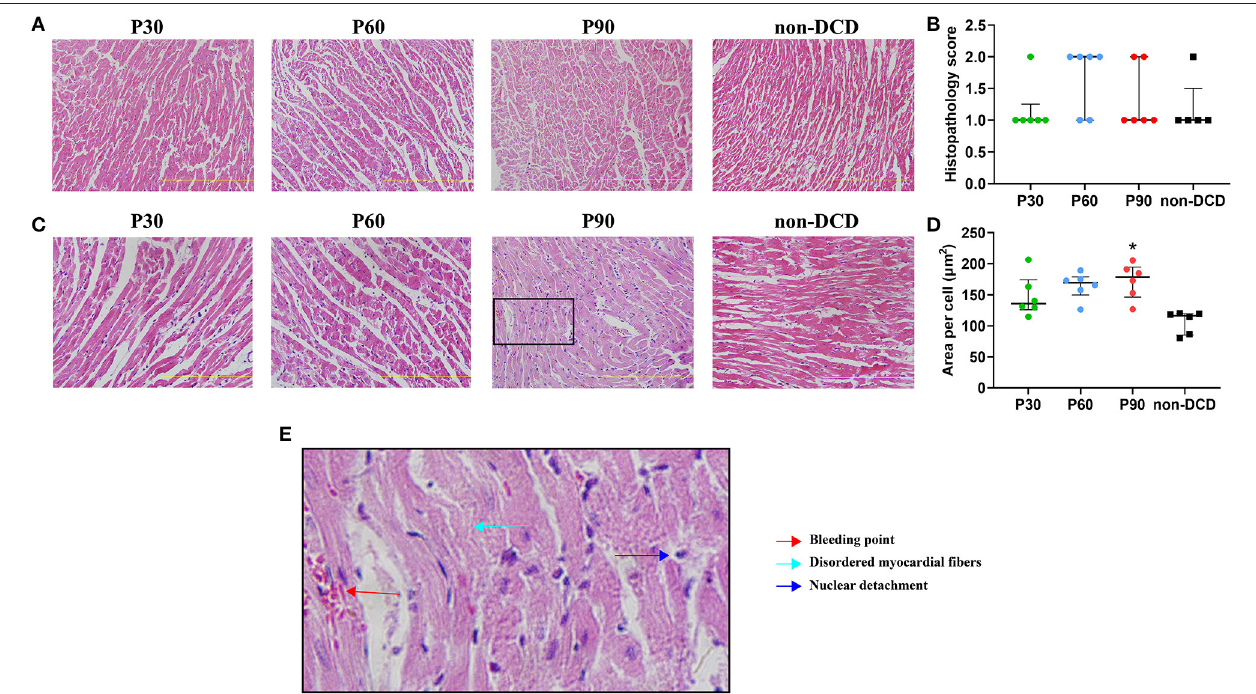
FIGURE 6 | Histopathological changes of donor heart during ESHP. (A) Representative photomicrographs of hematoxylin and eosin staining for donor hearts under magnification of 20 (Scale length: 200 µ m); (B) Histopathology score. n = 6 for P30, P60, and P90 groups, n = 5 for non-DCD group; (C) Representative photomicrographs of hematoxylin and eosin staining for donor hearts under magnification of 40 (Scale length: 100 µ m); (D) Mean area per cell. n = 6 for P30, P60, and P90 groups, n = 5 for non-DCD group; (E) Schematic diagram of damaged myocardium in hematoxylin and eosin staining. Data represented as median and interquartile range. DCD, Donation after circulatory death; ESHP, Ex situ heart perfusion. * p < 0.05 vs. non-DCD